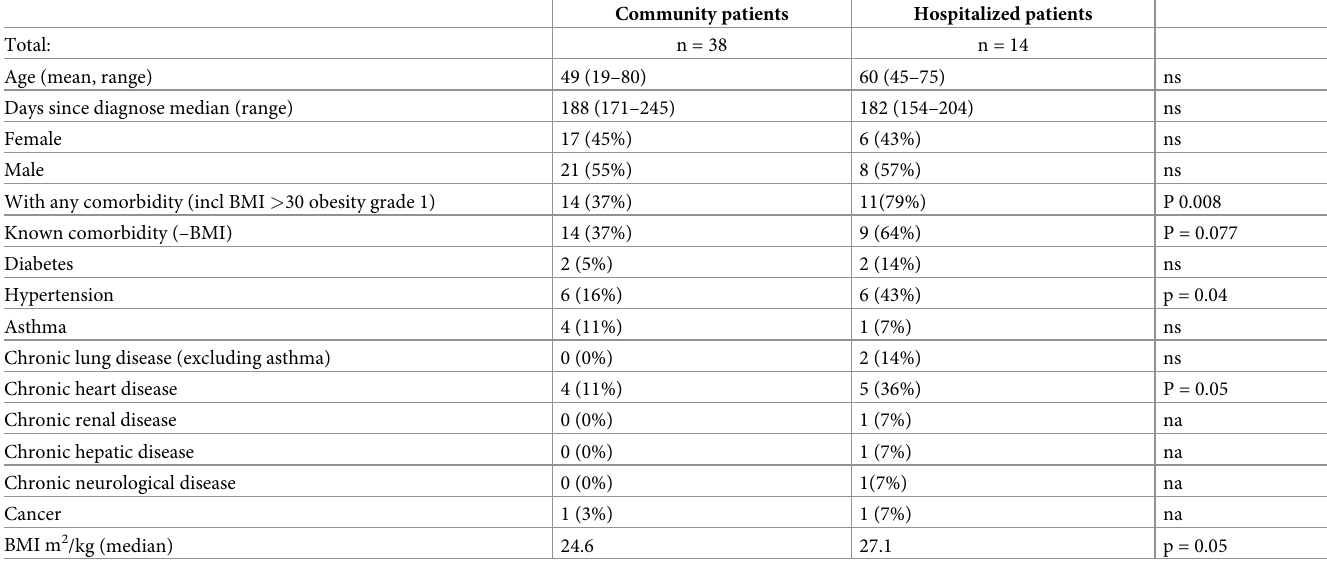
Table 1. Patient